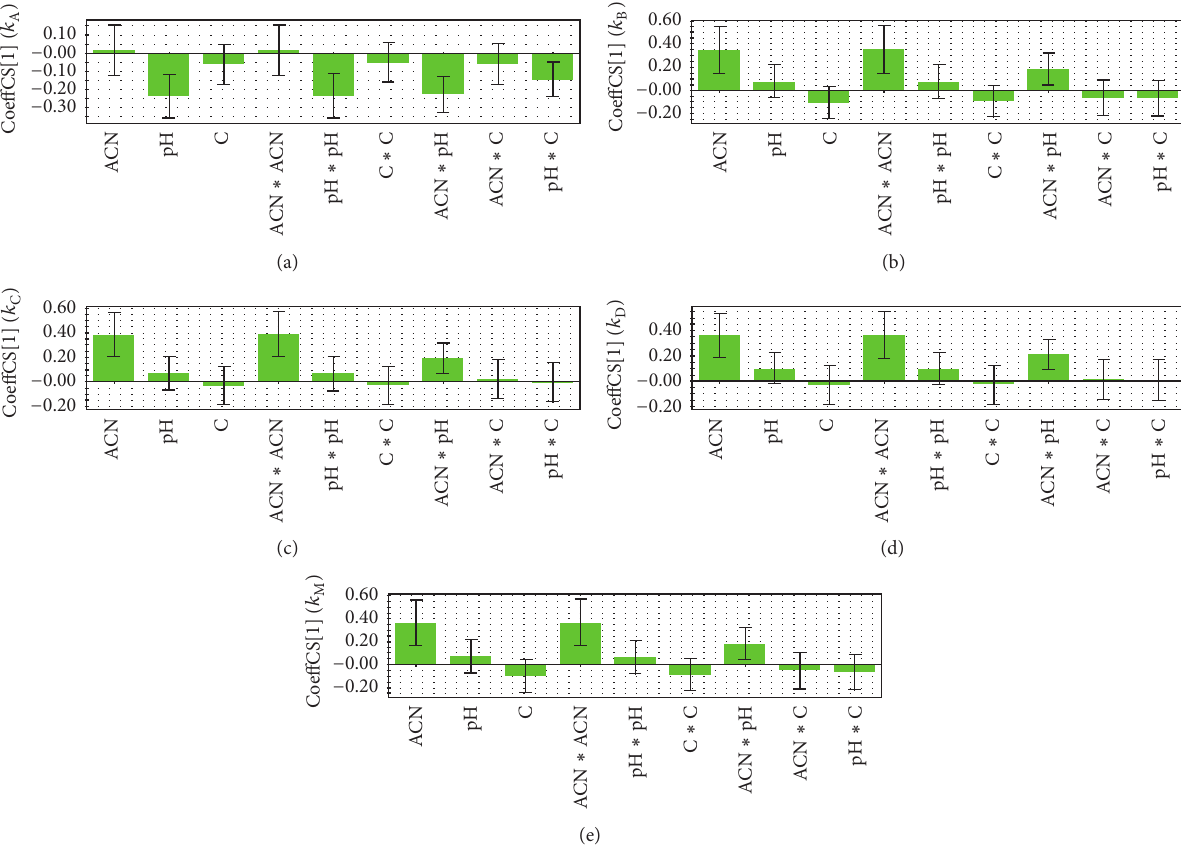
Figure 2: Plot of coefficients for the response variables: (a) 𝑘 A , (b) 𝑘 B , (c) 𝑘 C , (d) 𝑘 D , and (e) 𝑘 M .